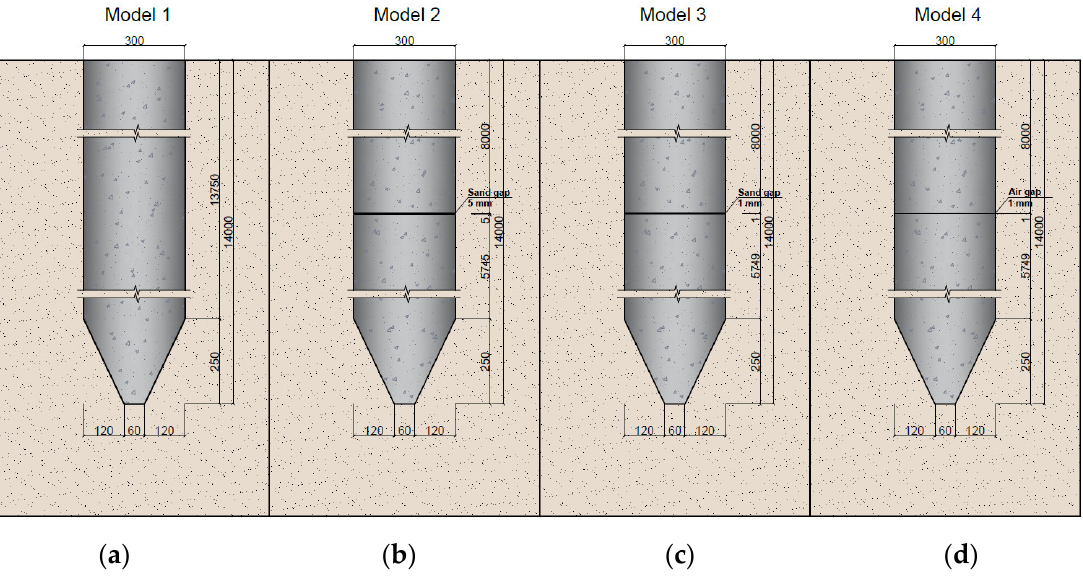
Figure 2. The layouts of synthetic driven pile models with different splice types: ( a ) single-section pile (without a splice)—Model 1; ( b ) 5 mm sand gap—Model 2; ( c ) 1 mm sand gap—Model 3; ( d ) 1 mm air gap—Model 4. Table 1. The properties of simulated materials.